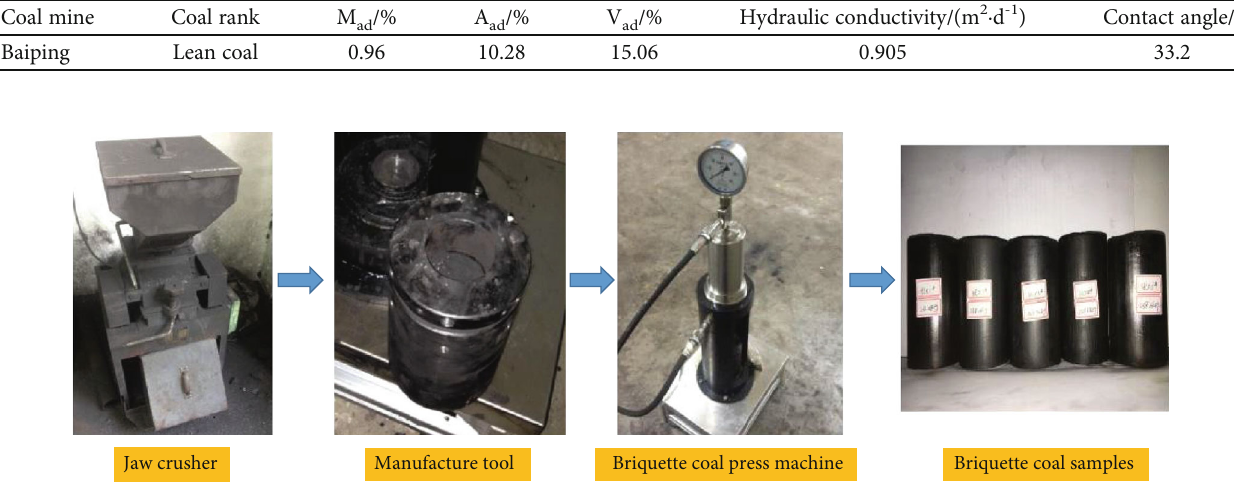
Figure 1: Preparation steps of briquette coal